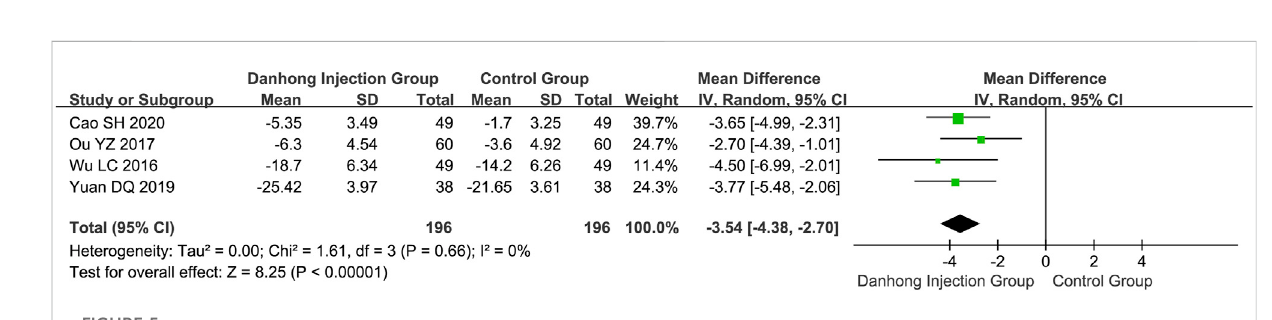
FIGURE 5 Meta-analysis of Hcy between DHI + WM and WM in patients with ischemic